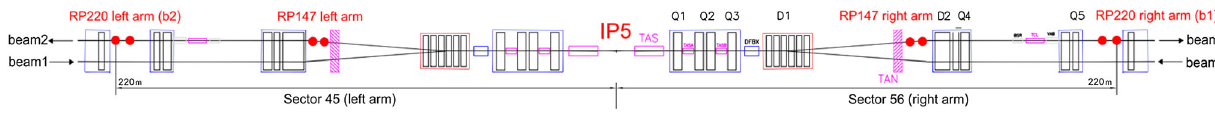
Fig. 1 Schematic layout of the LHC from IP5 up to the “near” and “far” Roman Pot units, where the near and far pots are indicated by full (red) dots on beams 1 and